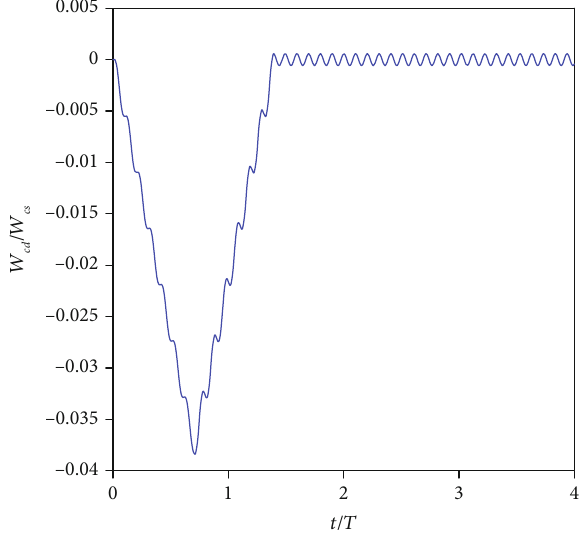
Figure 18: Central displacement of a simply supported beam subjected to symmetric triangular piezoelectric impulse for t d = 1 : 5 / L = ð 0 : 6,0 : 9 Þ . T , x a